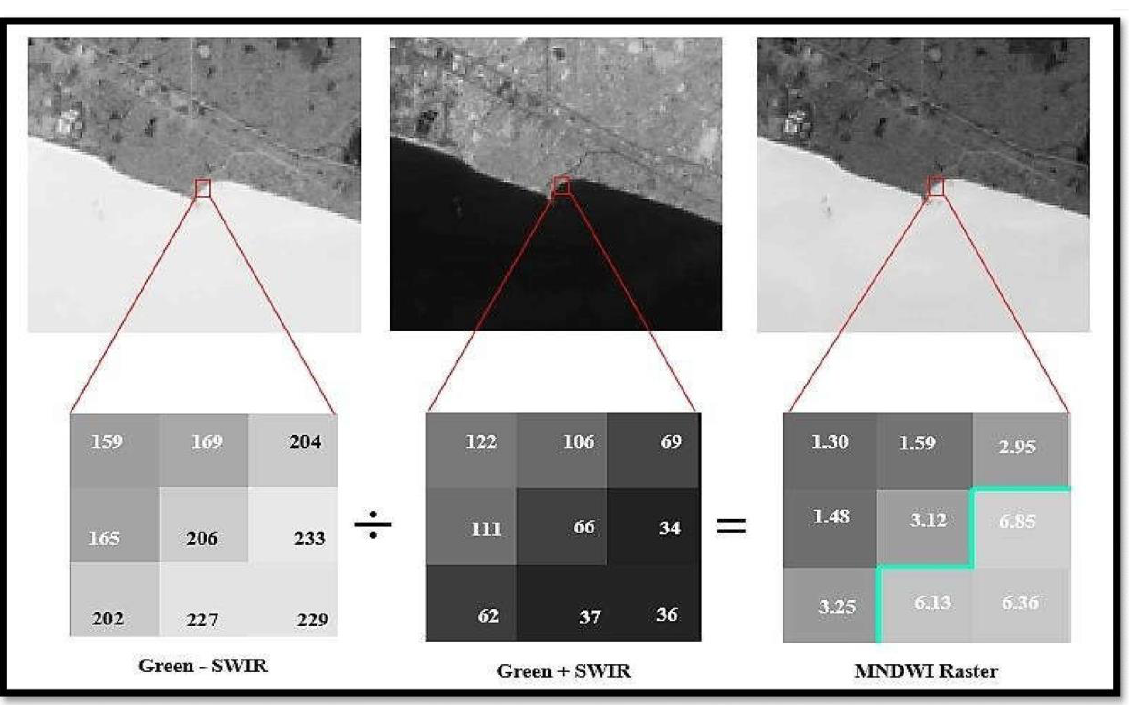
Figure 4. Band rationing of Landsat-OLI imagery of the southern coast for delineating the shoreline. Source : glovis.usgs.gov.